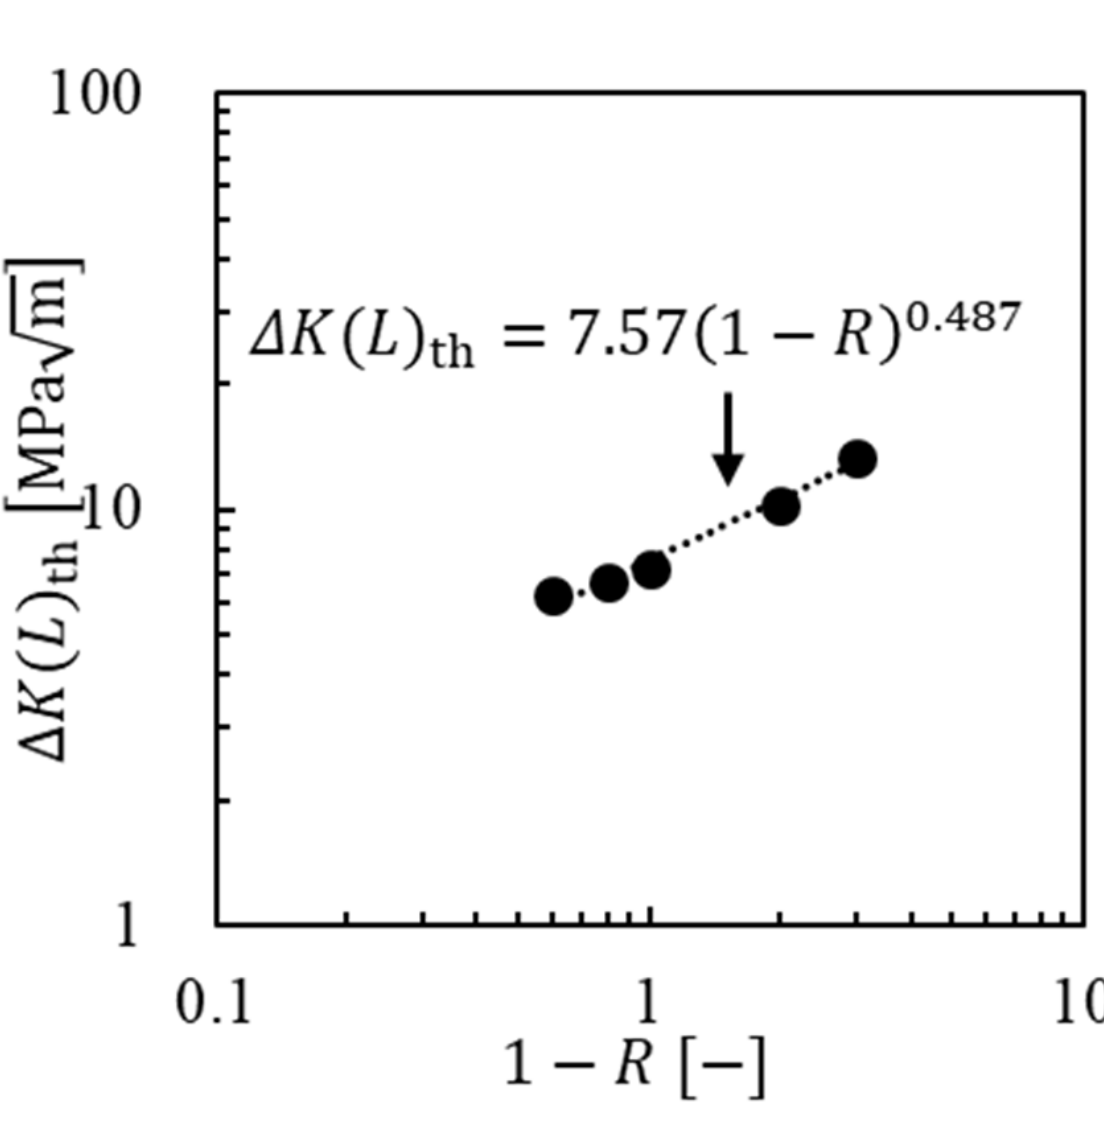
Figure 7. Relationship between ∆ K ( L )